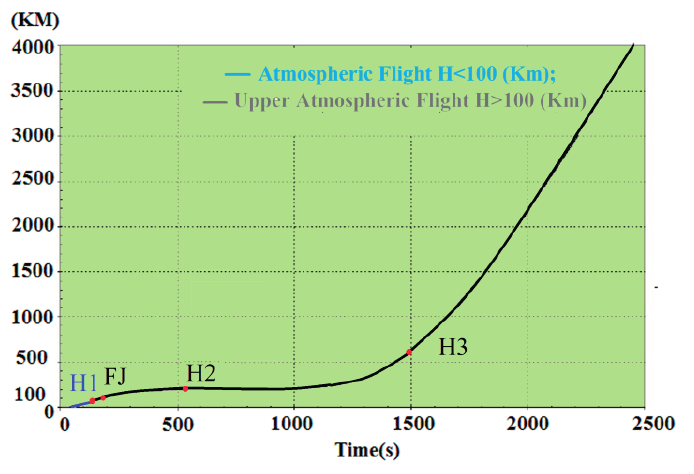
Figure 8. Dynamic loads applied to the Aian5 payload over the trajectory.